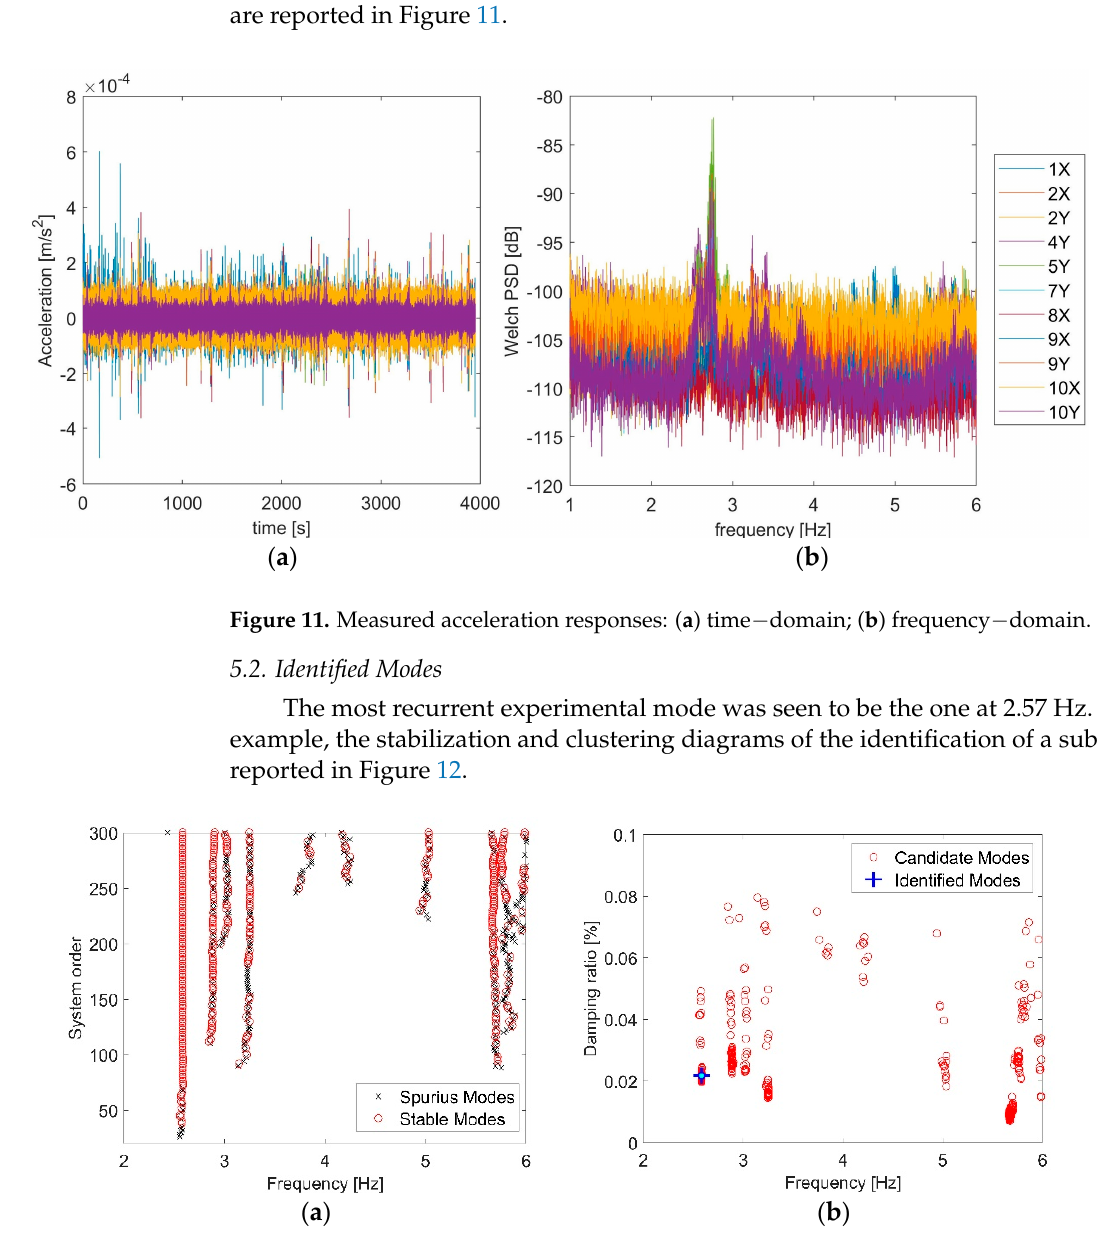
Figure 12. Stabilization ( a ) and clustering ( b ) diagram of the identification performed on the sixth sub − signal of setup 1 of the entire Pavilion V, with evidence of the mode at 2.57 Hz.